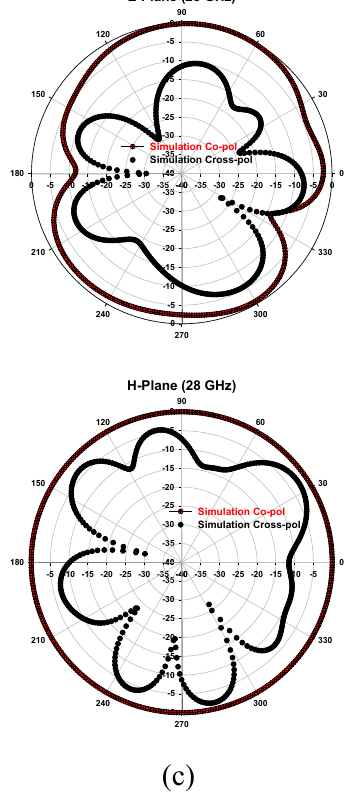
FIGURE 11. Radiation patterns of the proposed triple band antenna in E- Plane and H-Plane at 7.5 GHz (a), 9 GHz (b) and 28 GHz (c). The simulated gain and efficiency variation with the frequency are plotted in Fig. 12. It can be seen that the proposed antenna has radiation efficiency of 47%, 40% and 83% at the resonance frequencies 7.5 GHz, 9.01 GHz and 28.1 GHz respectively. The proposed antenna provides a gain of 3.96 dBi at 7.5 GHz, 3.05 dBi at 9.01 GHz and 5.86 dBi at 28 GHz.